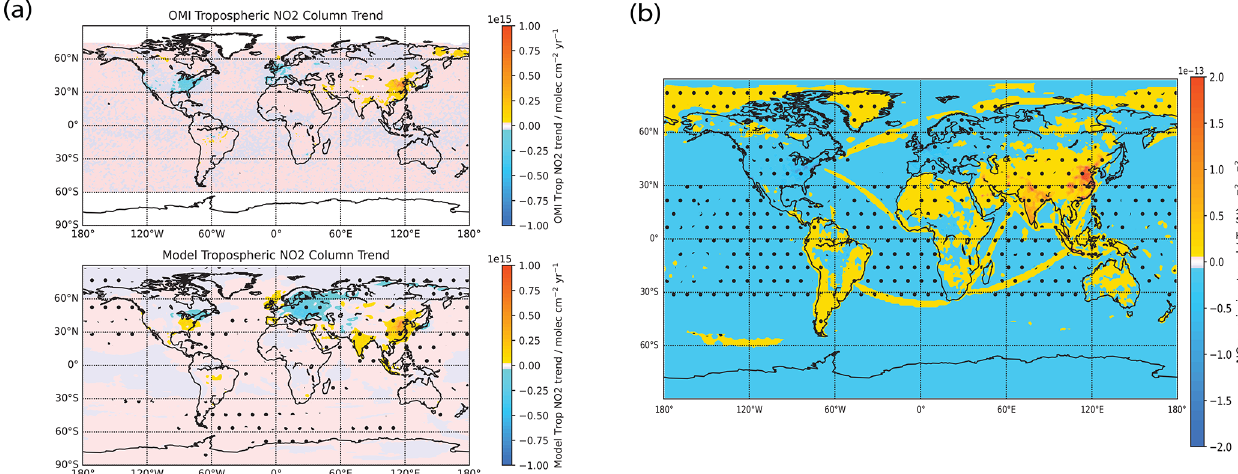
Figure 12. (a) Model comparison of annual mean tropospheric NO 2 column trends with OMI tropospheric NO 2 observations processed by Goldberg et al. (2021) over the 2005–2014 period. (b) NO x emission trends over the 2005–2014 period. Trends and stippling are as per Fig. 3. We see that there is general agreement between the emissions and the model tropospheric NO 2 column. Also, both show significant positive trends over South Asia and eastern China and significant negative trends over the eastern USA and western Europe. These are in turn also consistent with the OMI tropospheric NO 2 column observations. Overall, these findings lend confidence in our model NO x trends from 2005 to 2014.